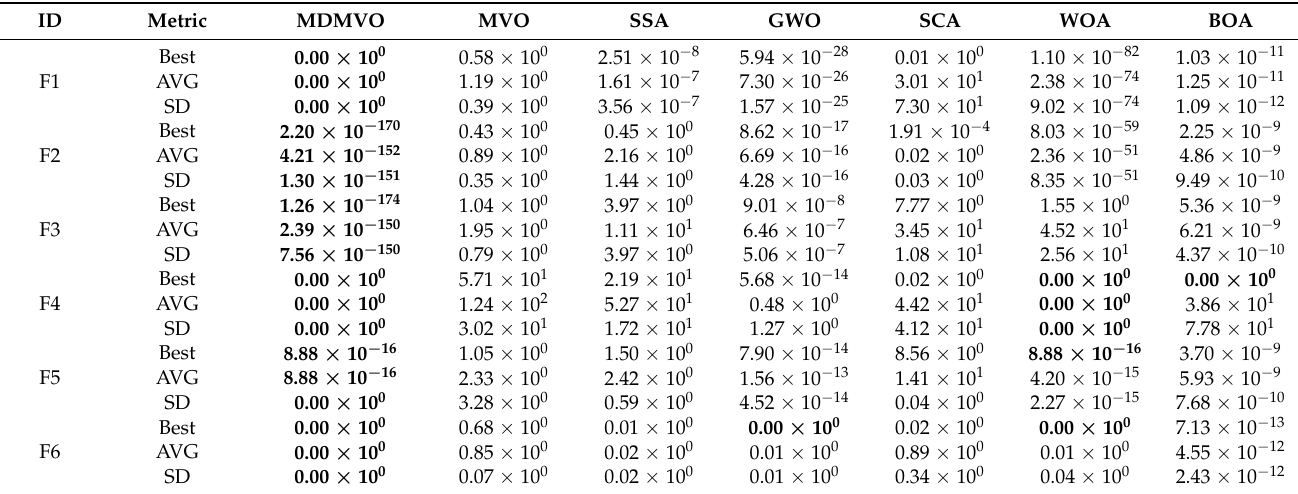
Table 4. The findings from tests on unimodal and multimodal